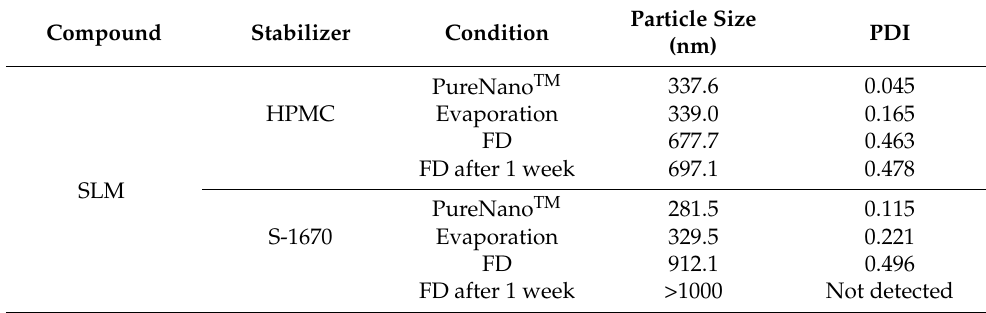
Compound Stabilizer